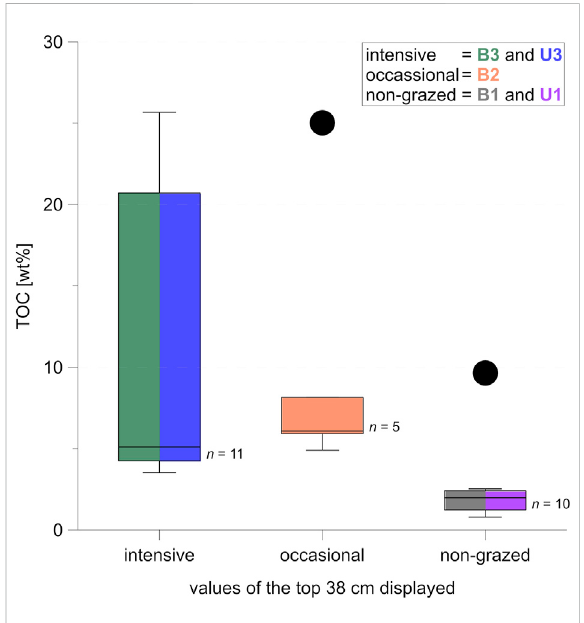
FIGURE 8 Boxplots for total organic carbon (TOC) data of all samples from the uppermost 38 cm of all intensive, occasional, and non- grazed sampling sites; sites B3 and U3 are combined into the “ intensive ” boxplot, B2 is shown in the “ occasional ” boxplot, and B1 and U1 are combined into the “ non-grazed ” boxplot; the median is shown by the horizontal line within each box; box margins show the upper and lower quartile; whiskers mark minimum and maximum values; outliers (indicated by dots) are more than 1.5 box lengths away from box margins; colors indicate which sites are represented in which